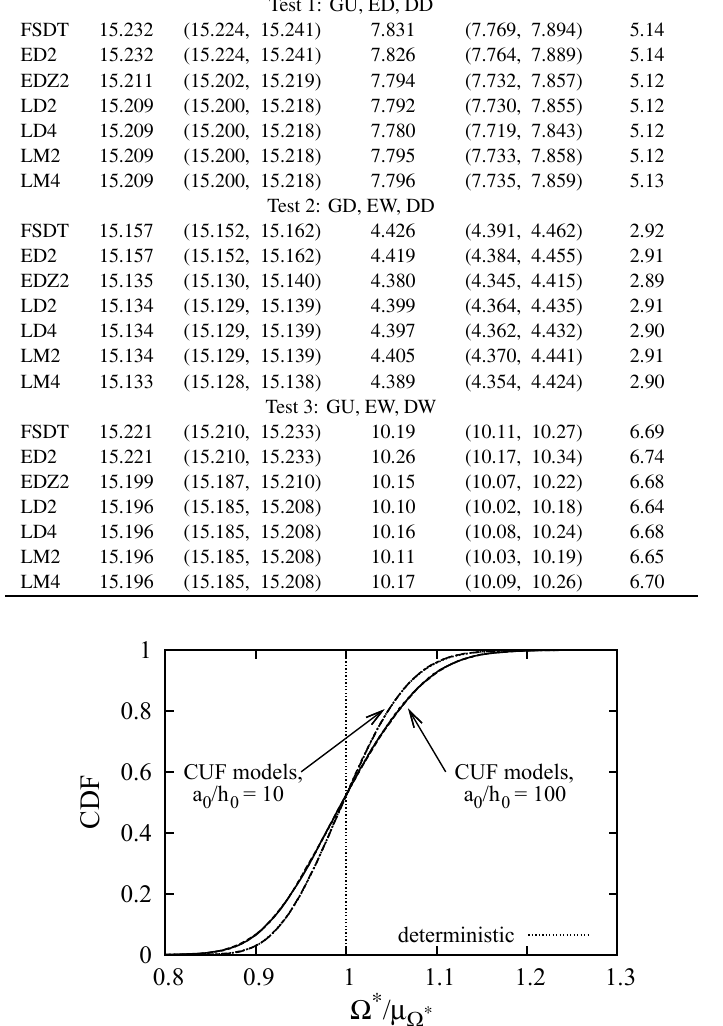
Fig. 6. Cumulative Distribution Function for the symmetric laminate, fi rst material, a 0 /h 0 = 100 and a 0 /h 0 = 10, test 3. relatively thick plates. The tests yield similar statistic results. Ω ∗ is not very sensitive to stochastic perturbations in the material elastic properties. Both Weibull or Gaussian PDFs can be assumed as probabilistic model for the elastic properties in order to evaluate the second order statistics of Ω ∗ . The difference in the standard deviations is mainly due to the difference in the left tail of the CDFs as shown in Fig. 8. For an anti-symmetric laminate made of the second material, tests have been done considering all the input parameters to be random. In test 4 (GG, EW, DW) a Weibull PDF is assumed as probabilistic model for material properties, while in test 5 (GG, EG, DG) a Gaussian PDF is used. Geometrical data are sampled according to a Gaussian PDF. Results are presented in Tables 10 and 11. Since results are similar, both a Weibull or a Gaussian PDFs can be also assumed for the material density, unless small fractile values are requieed. The high value of CV Ω ∗ % is due to the probabilistic model assumed for the geometrical